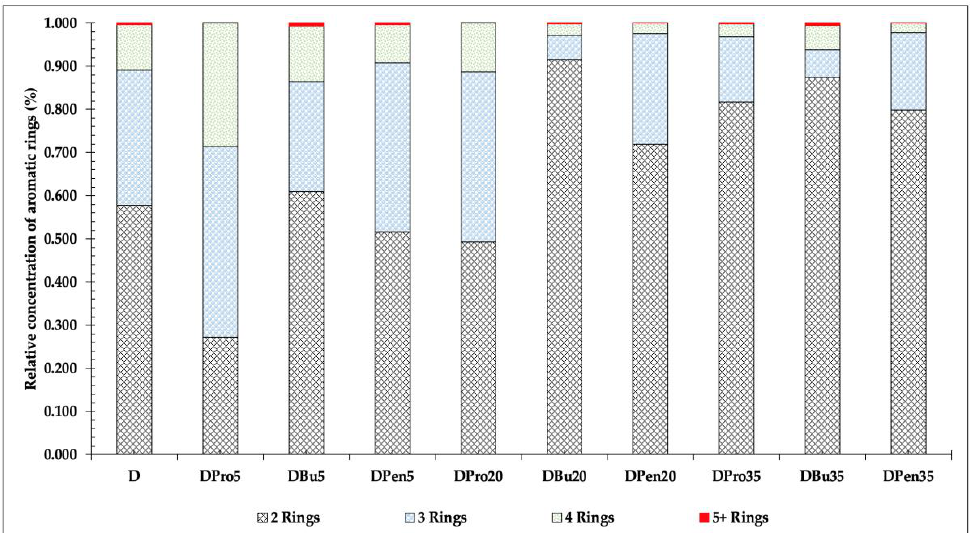
Figure 6. Relative distribution of PAH by number of aromatic rings .